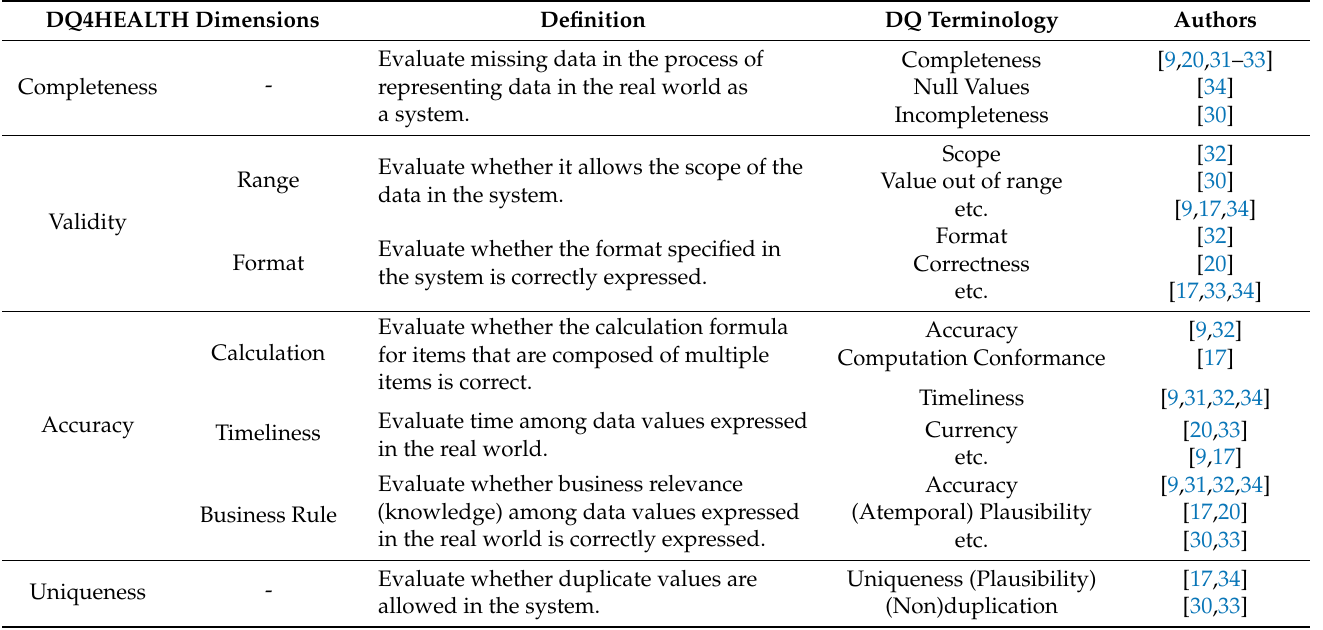
Table A1. The Literature Review Result of Information System